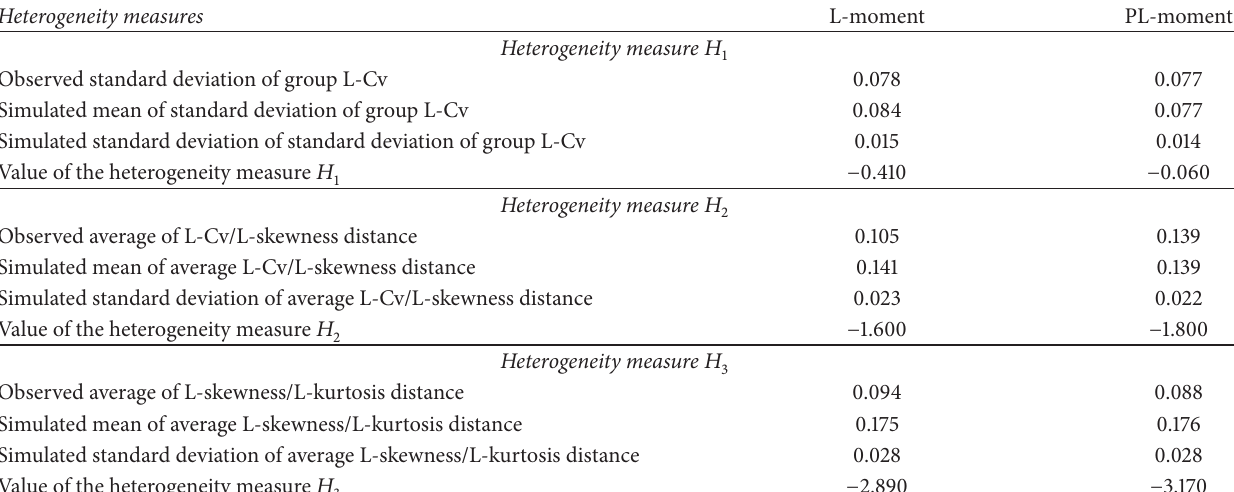
Table 4: Heterogeneity measures for the study region based on L-moments and PL-moments.